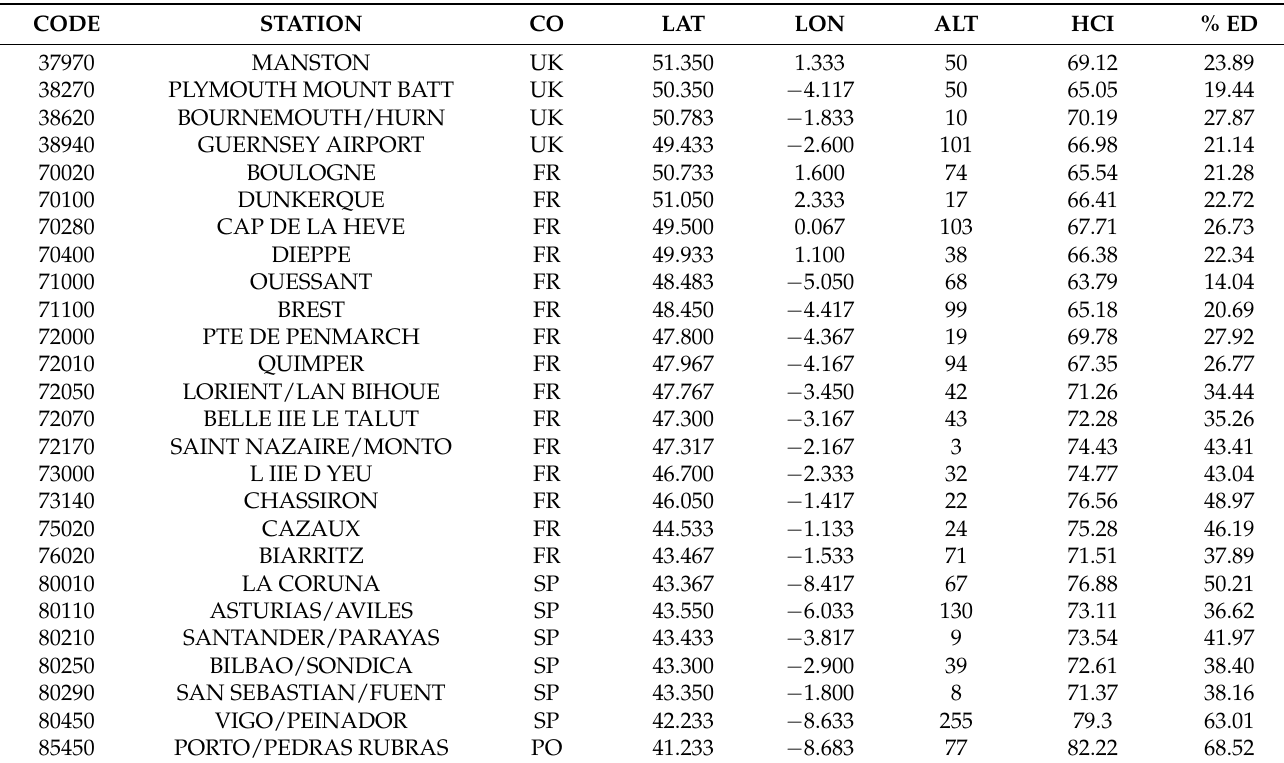
Table A1. Location of the meteorological stations. CODE stands for WMO code; CO stands for Country; LAT, LON and ALT stand for latitude, longitude (in degrees) and altitude (a.s.l); HCI stands for summer (JA) HCI: Beach average value; % ED stands for average ratio of days categorized as excellent (HCI: Beach > 80).